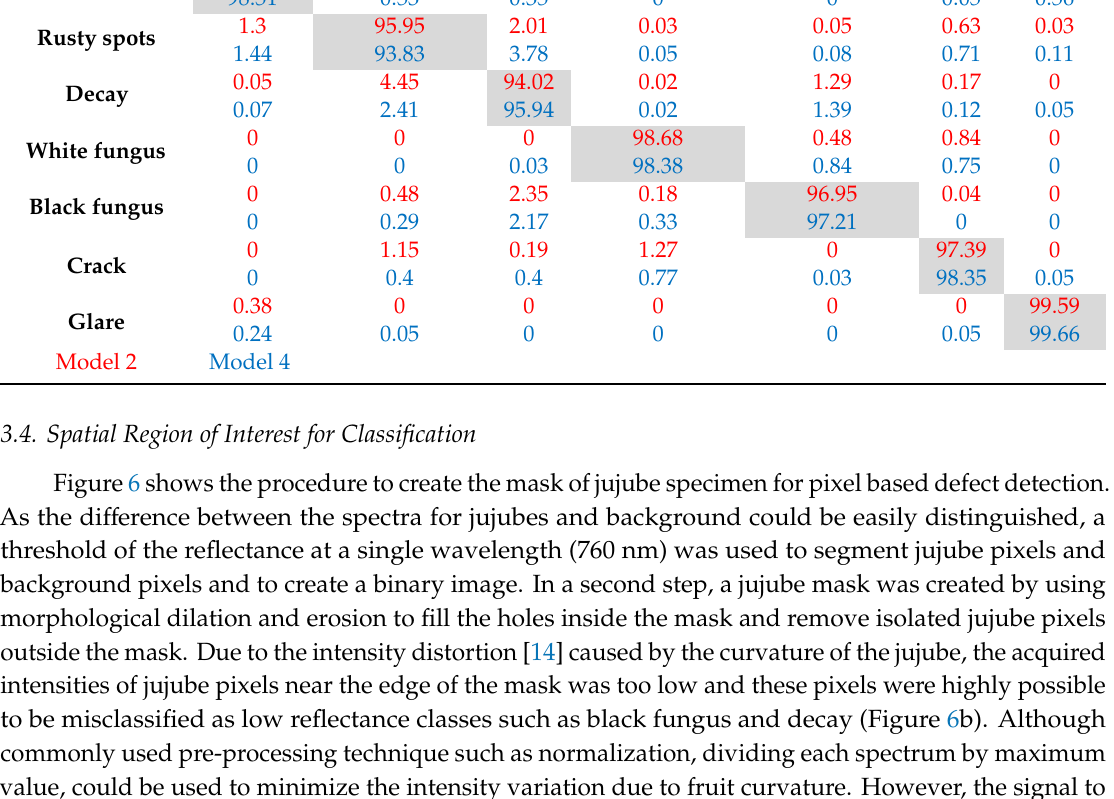
Actual Normal Rusty Spot